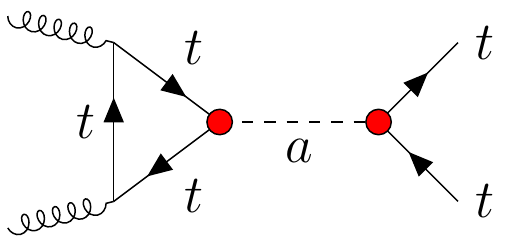
Figure 9 . One-loop contribution to ALP production via gluon-fusion, and its decay to a pair of